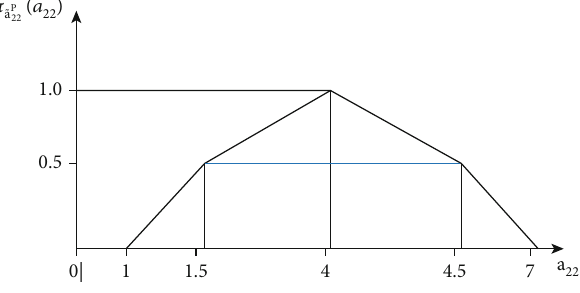
Figure 4: Graphical representation of pentagonal fuzzy number ~ a P